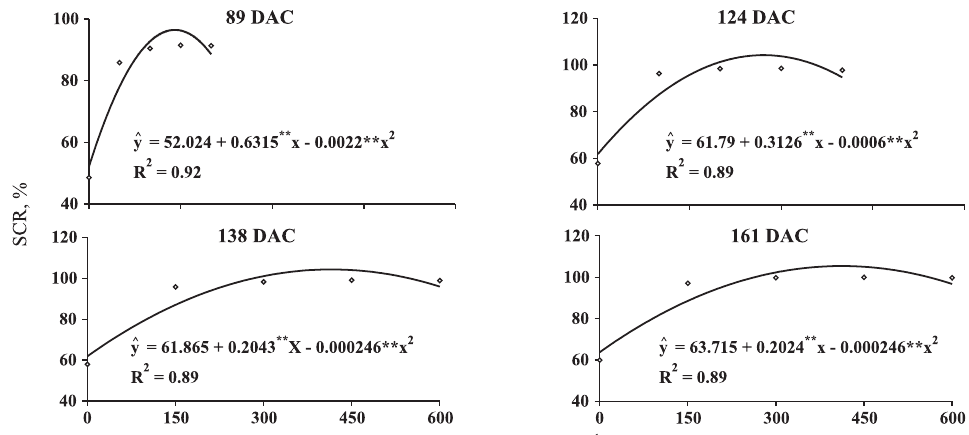
Figure 1. Soil cover rate (SCR) of Bermuda grass, according to N rates, 89, 124, 138, and 161 days after